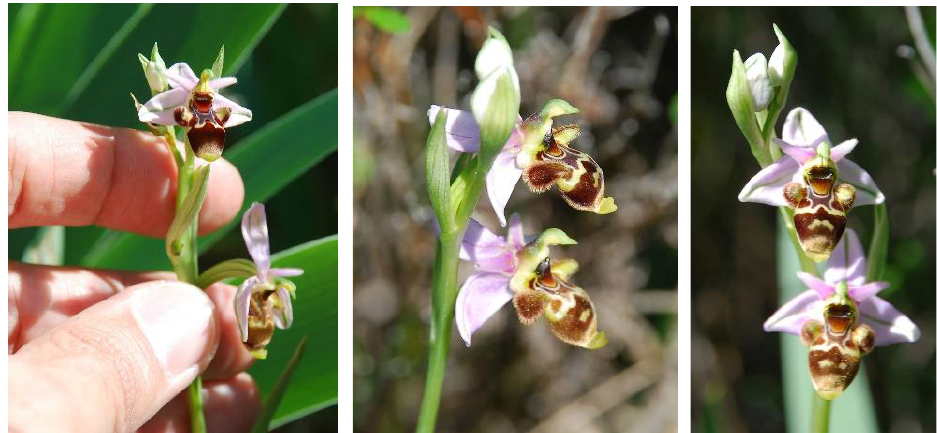
Figure 4. The studied plant species: Ophrys scolopax (woodcock bee orchid). Plant 10 – 40 cm tall, with inflorescence of up to 12 flowers. Sepals ovate-lanceolate, white to purple-violet, with a green midrib. Petals triangular-lanceolate, similar in colour to the sepals. Labellum 3-lobed at the base and reddish-brown to purple. Lateral lobes small and densely pilose, and the median with dense marginal pilosity. Basal field reddish-brown, surrounded by an H- or X-shaped speculum. Apical appendix distinctly conspicuous, acute, greenish yellow (photos by J.A. González and F. Amich).